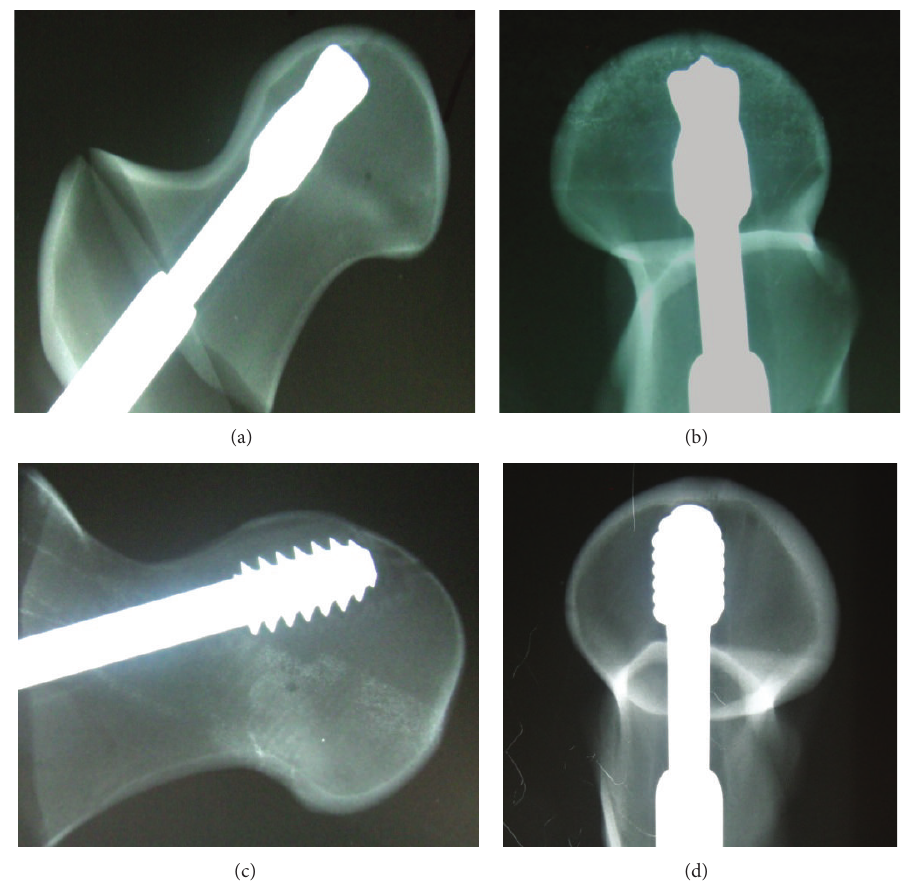
Figure4:X-rayaftercompressiontestingatSCpositioninDHSbladeandDHSgroup.In(a)and(b),bladeDHSscrewreachedthetopwithout cutting out. There was no further displacement or rotation. In (c) and (d), conventional DHS screw touched the cortex with migration tract shadow inside femoral head. Table 1: The displacement and rotation degree among five positions both in DHS and DHS blade groups. Displacement (mm) Rotation degree ( ∘ ) Positions DHS blade DHS DHS blade DHS CC 1.372 ± 1.0127 5.214 ±